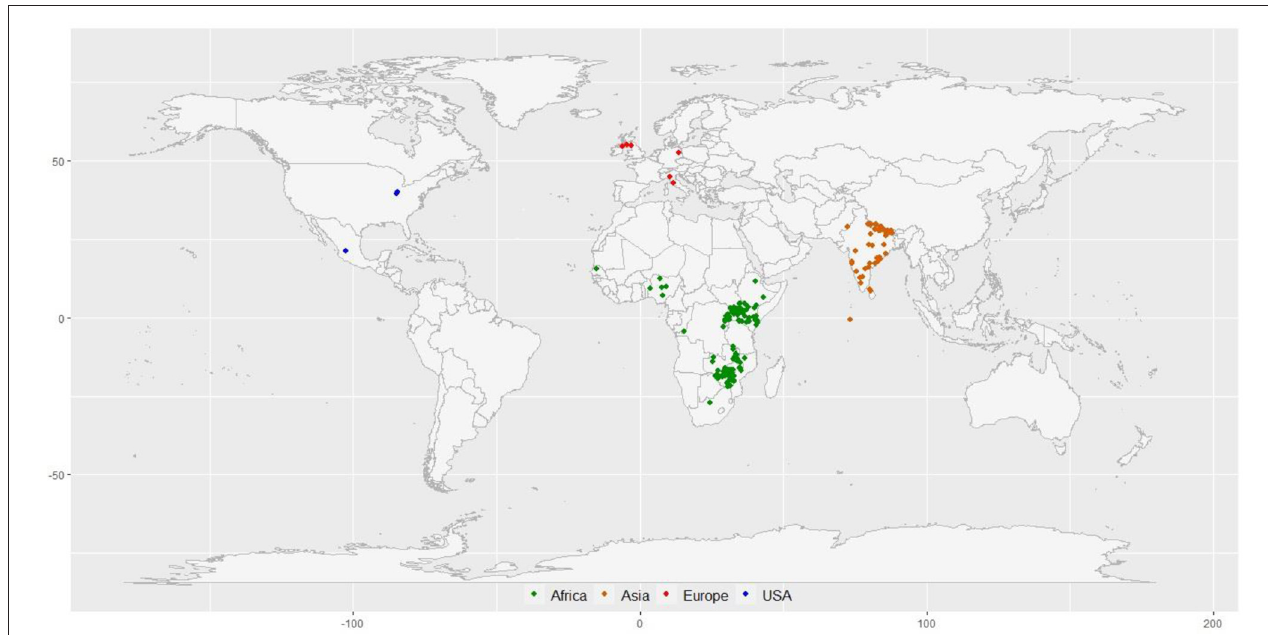
FIGURE 1 | The geographical distribution of 297 finger millet accessions with known geo-coordinates distributed in 23 countries around the